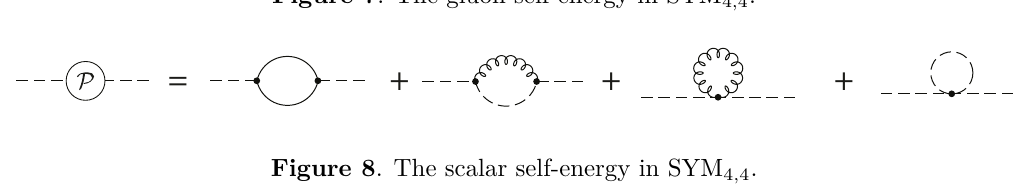
Figure 7 . The gluon self-energy in SYM 4 , 4 .